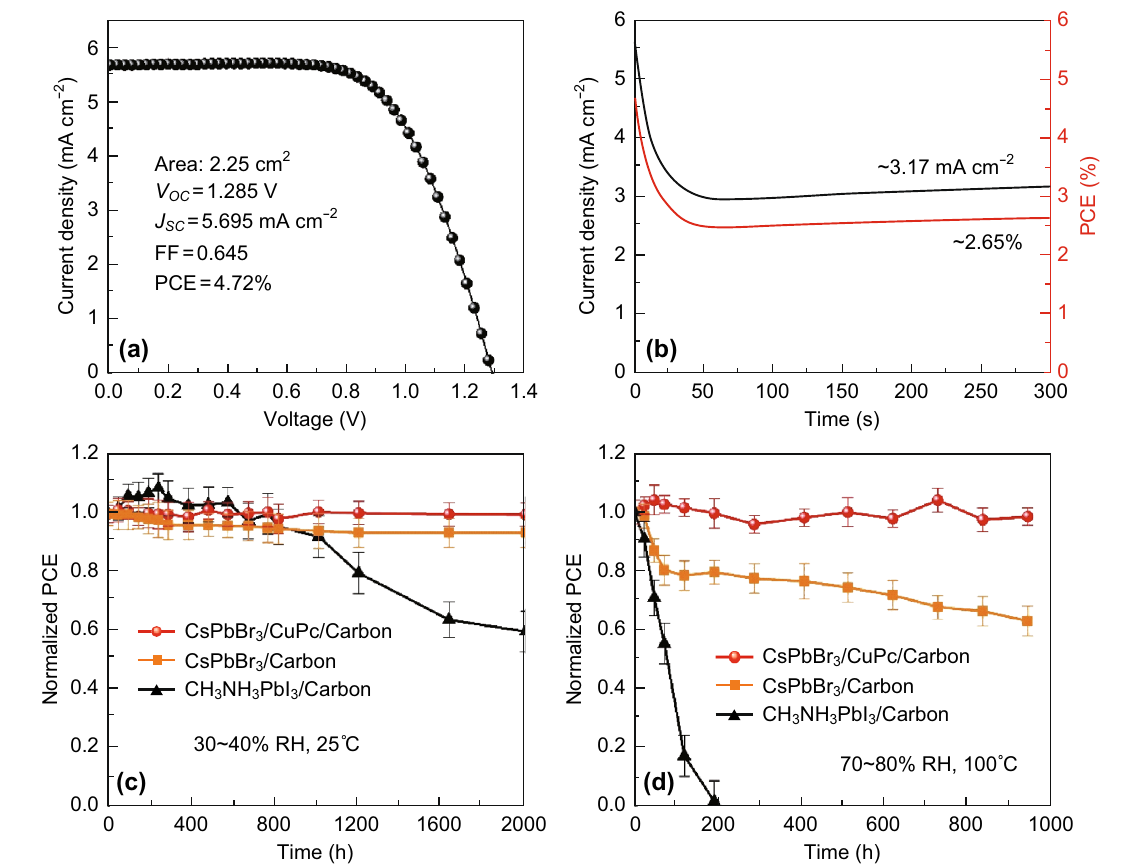
Fig. 6 a J – V plot of the carbon-based perovskite solar cell with a large active area of 2.25 cm 2 . b Stabilized power output measurement for the large-area PSC. c Normalized PCE of CsPbBr 3 /CuPc/carbon-, CsPbBr 3 /carbon-, and CH 3 NH 3 PbI 3 /carbon-based PSCs versus storage time in ambient air (30–40% RH, 25 (cid:3) C) without encapsulation. d Normalized PCE of CsPbBr 3 /CuPc/carbon-, CsPbBr 3 /carbon-, and CH 3 NH 3 PbI 3 /- carbon-based PSCs versus storage time heated at high temperature (100 (cid:3) C) in a high-humidity ambient environment (70–80% RH, 100 (cid:3) C) without